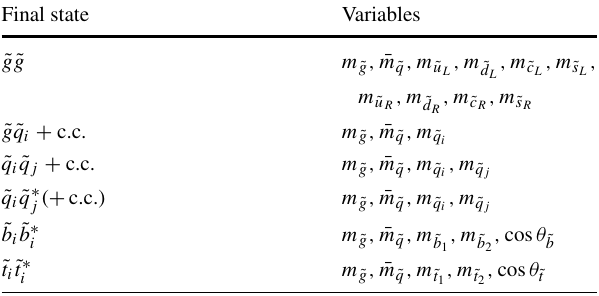
Table 1 List of all available cross-sections in xsec . Explicit first and second-generation squarks ˜ q i can be ˜ u L , ˜ d L , ˜ c L , ˜ s L , ˜ u R , ˜ d R , ˜ c R or ˜ s R , whilst ¯ m ˜ q denotes the average over all eight of these masses. Where the charge-conjugate process is distinct from the original, xsec returns the sum of the cross-section for the process and its conjugate (as indicated; for q i ˜ q ∗ , the conjugate is only distinct when i (cid:11)= j j